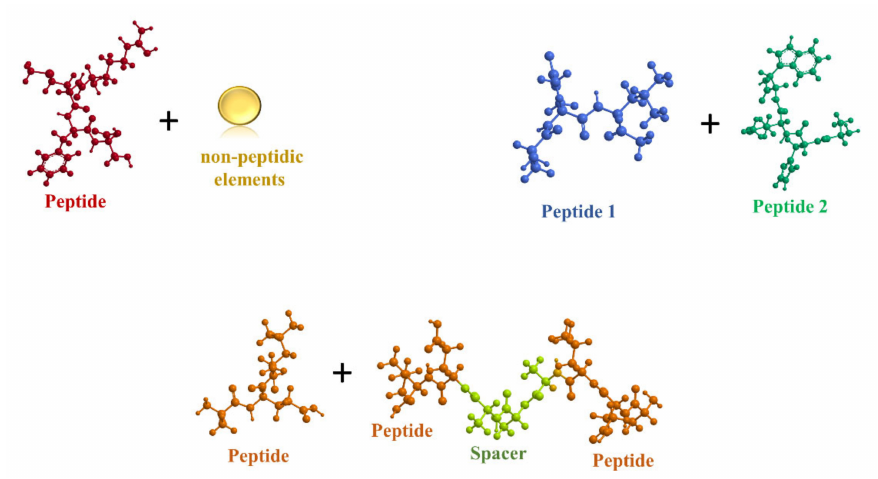
Figure 2. Most common strategy to obtain co-assembly